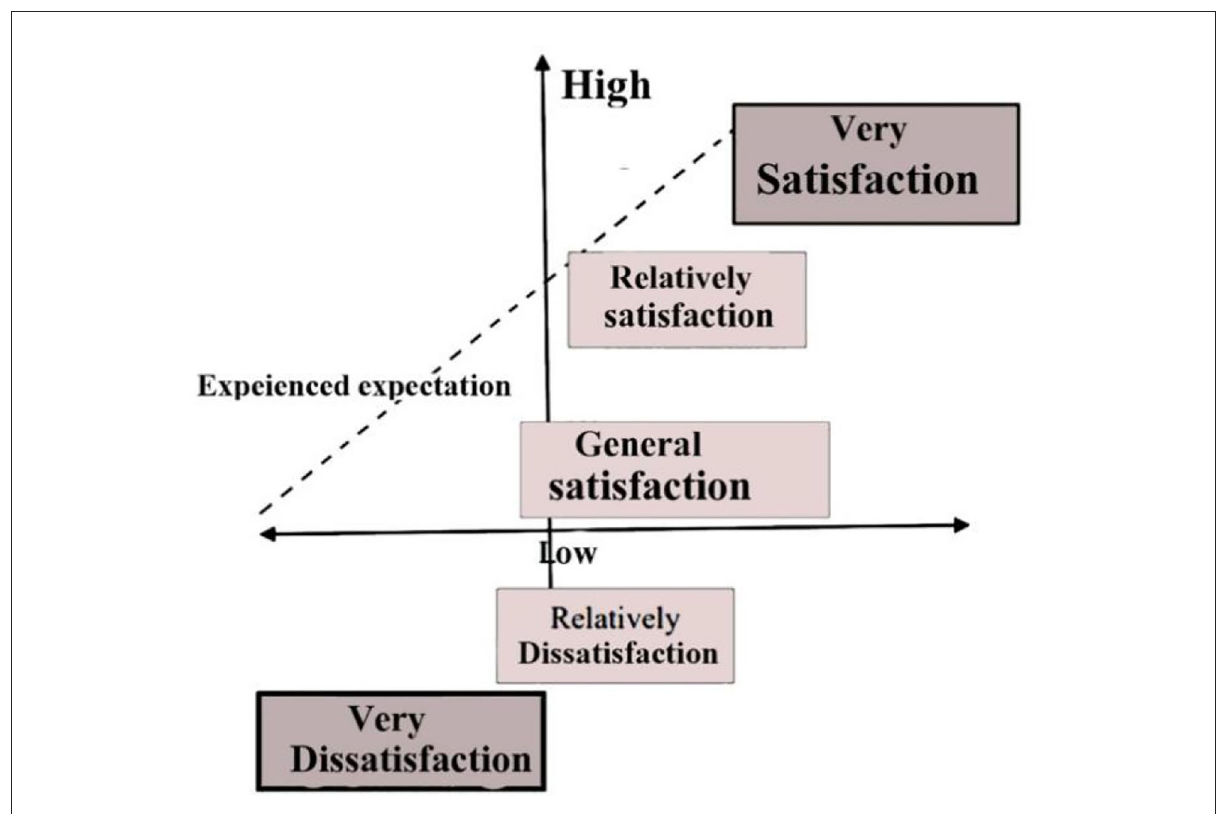
FIGURE3 Customer